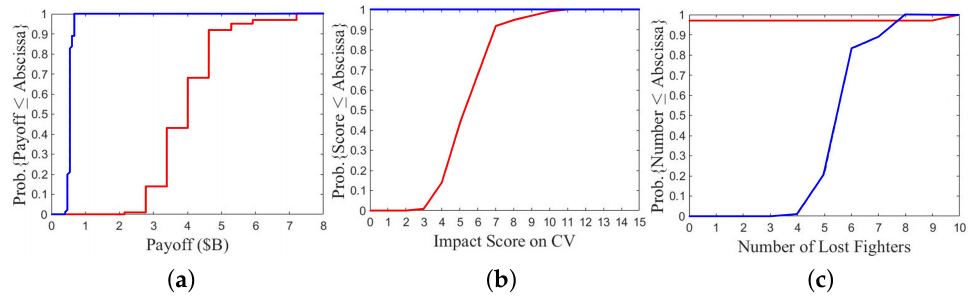
Figure 21. Specific P 2 SO run on A1/B2 over 100 games, cumulative distribution of ( a ) payoff; ( b ) impact score on CV, ( c ) lost fighter; ———: fleet A, ———: fleet